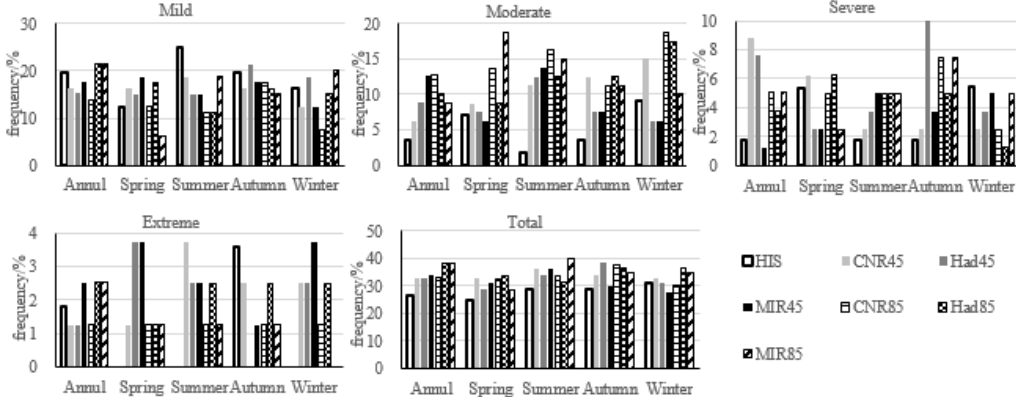
Figure 7. Annual and seasonal drought frequencies of different drought categories historically and in the